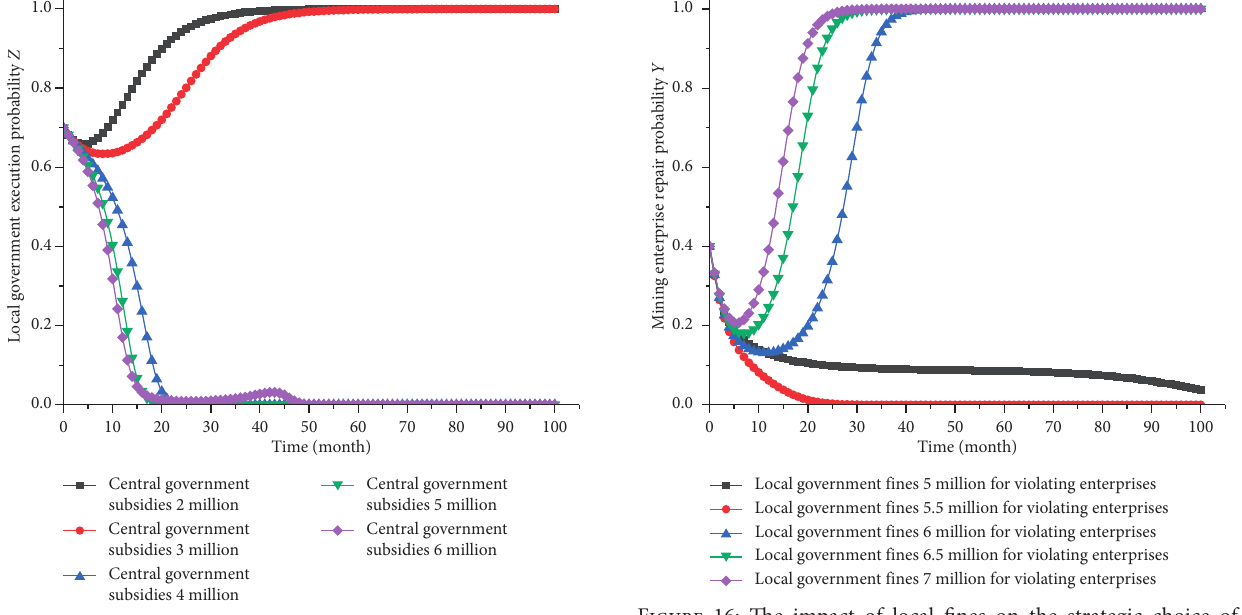
Figure 14: The effect of central subsidies on the selection of local government strategies.